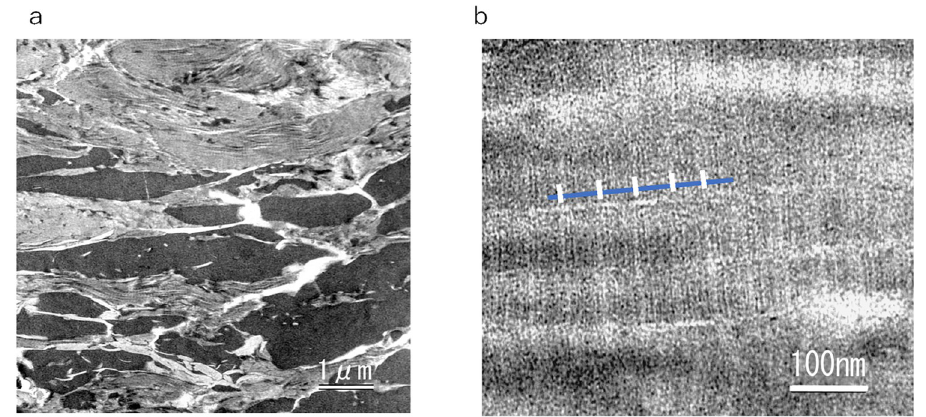
Fig 4. Transmission electron microscope images of mammoth soft tissues. (a) Lung section from Dima. (b) Higher magnification of same section. The blue bar indicates collagen molecule length; the white bars indicate the 67-nm- period banding pattern of collagen fibers.